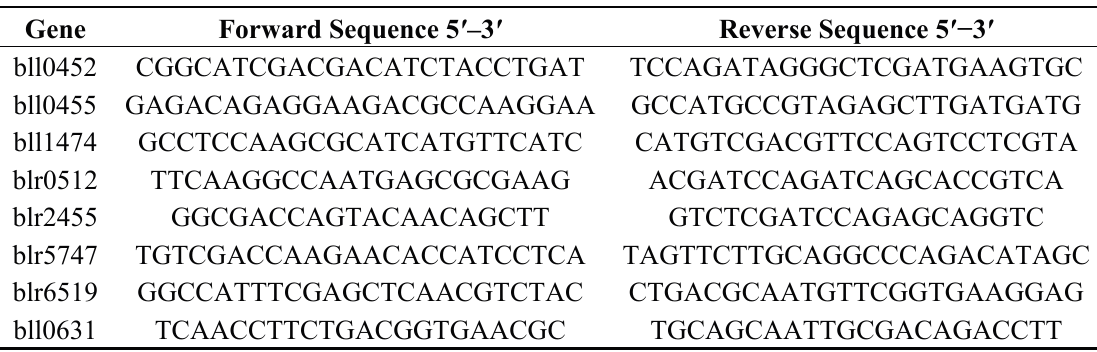
Table 5. Primers used for qRT-PCR